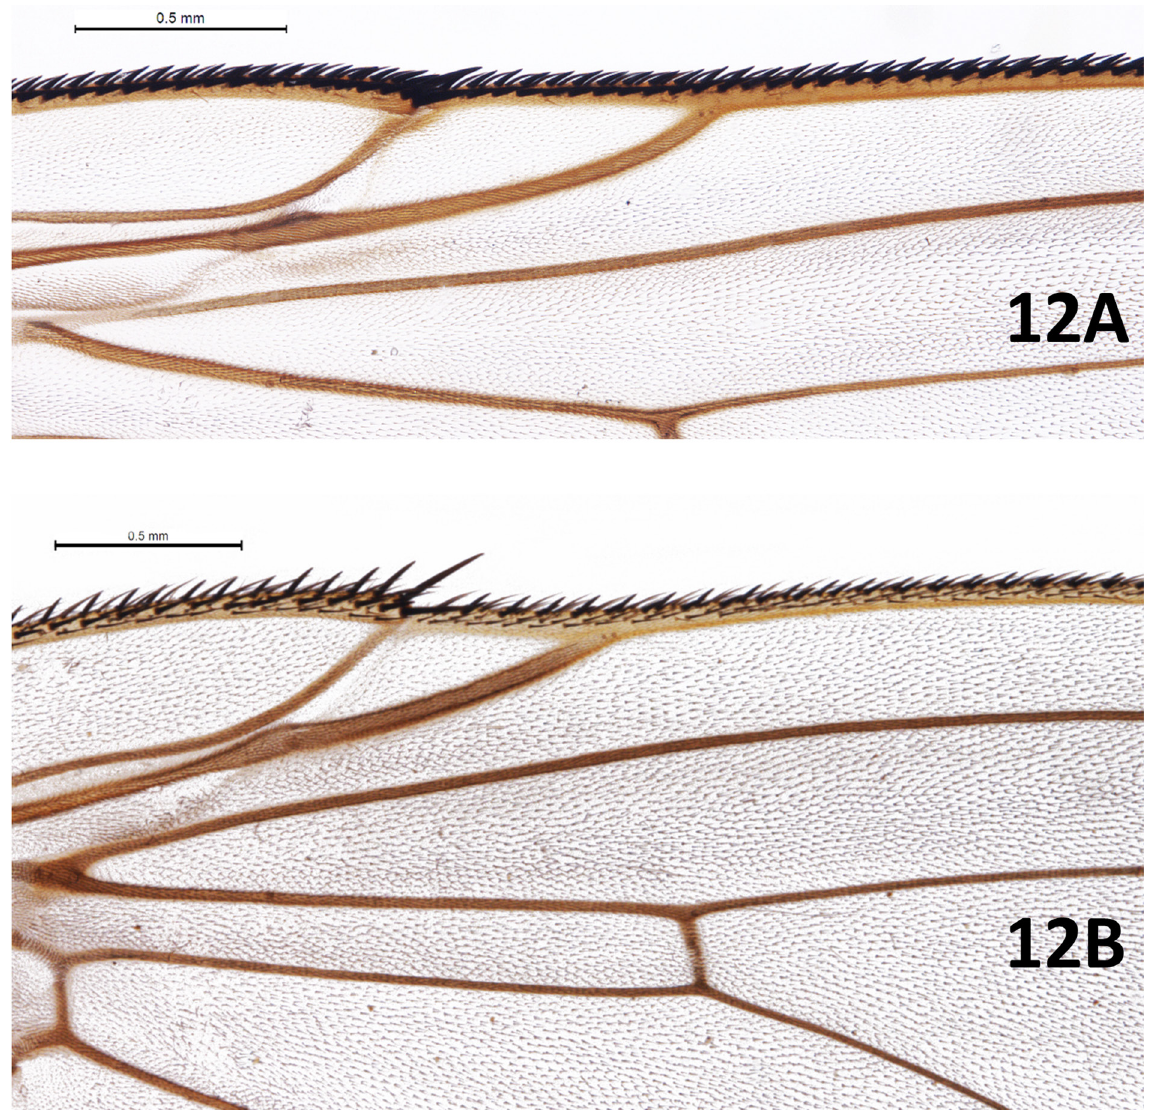
Fig. 12. ♀♀ of Muscidae Latreille, 1802. A . Muscina stabulans (Fallén, 1823), detail of wing showing CS1‒3, dorsal view. B . Palpibracus trivittatus (Malloch, 1934), detail of wing showing CS1‒3, dorsal